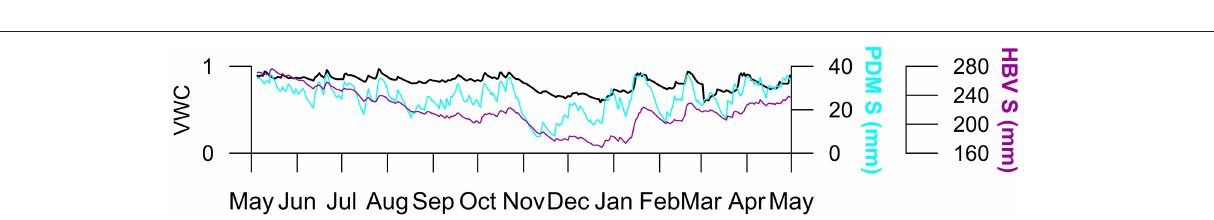
FIGURE 9 | Energy fluxes measured with the eddy-covariance method vs. energy fluxes estimated with the energy balance method. Energy balance method is highly dependent on the variance of the temperature ( σ T).